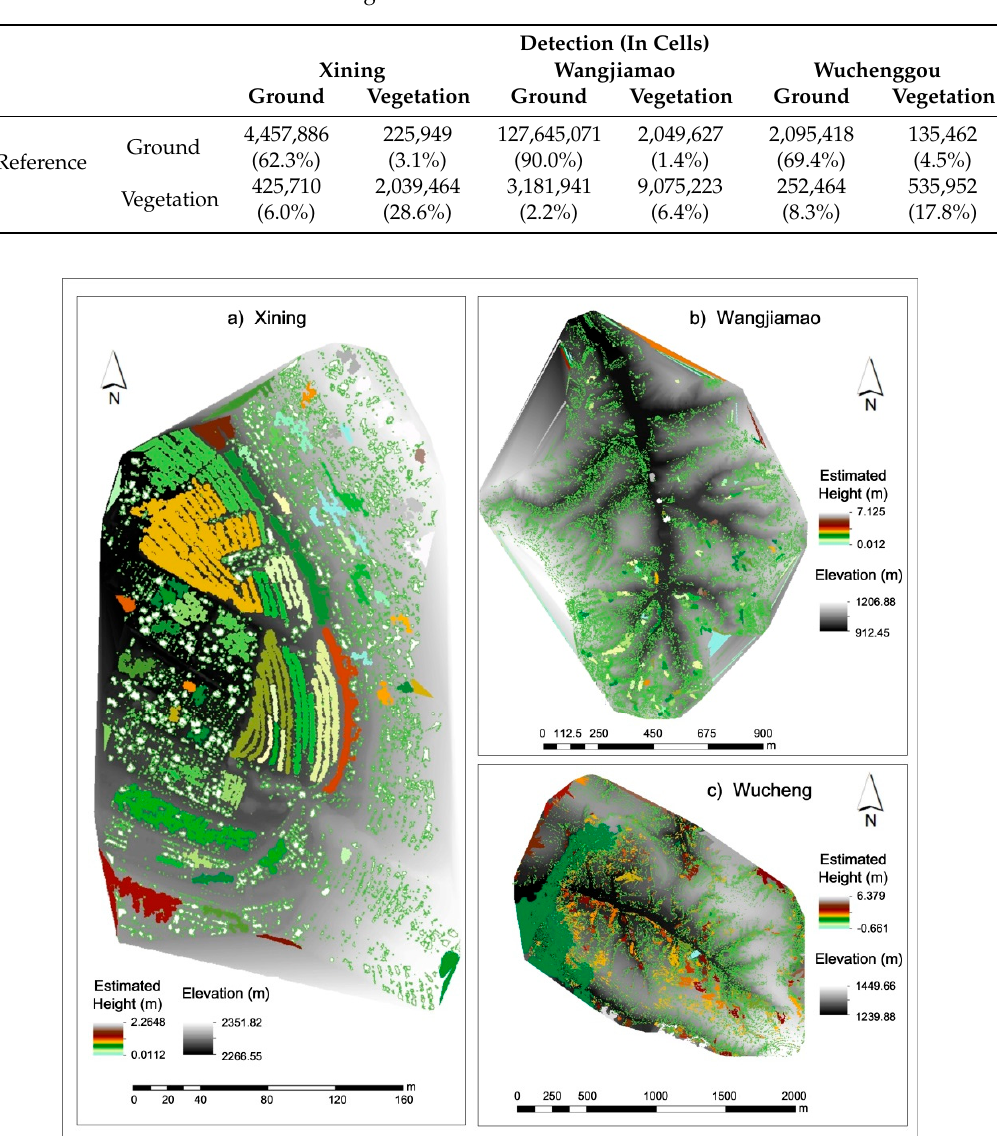
Figure 5. Vegetation identification results. ( a ) Xining; ( b ) Wangjiamao; ( c ) Wucheng. Base map is the digital surface model (DSM), and the estimated vegetation height is colored. digital surface model (DSM), and the estimated vegetation height is